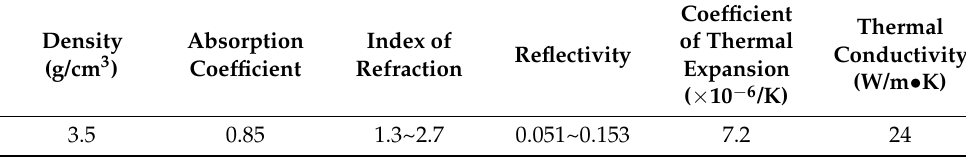
Table 1. Al 2 O 3 ceramic properties.